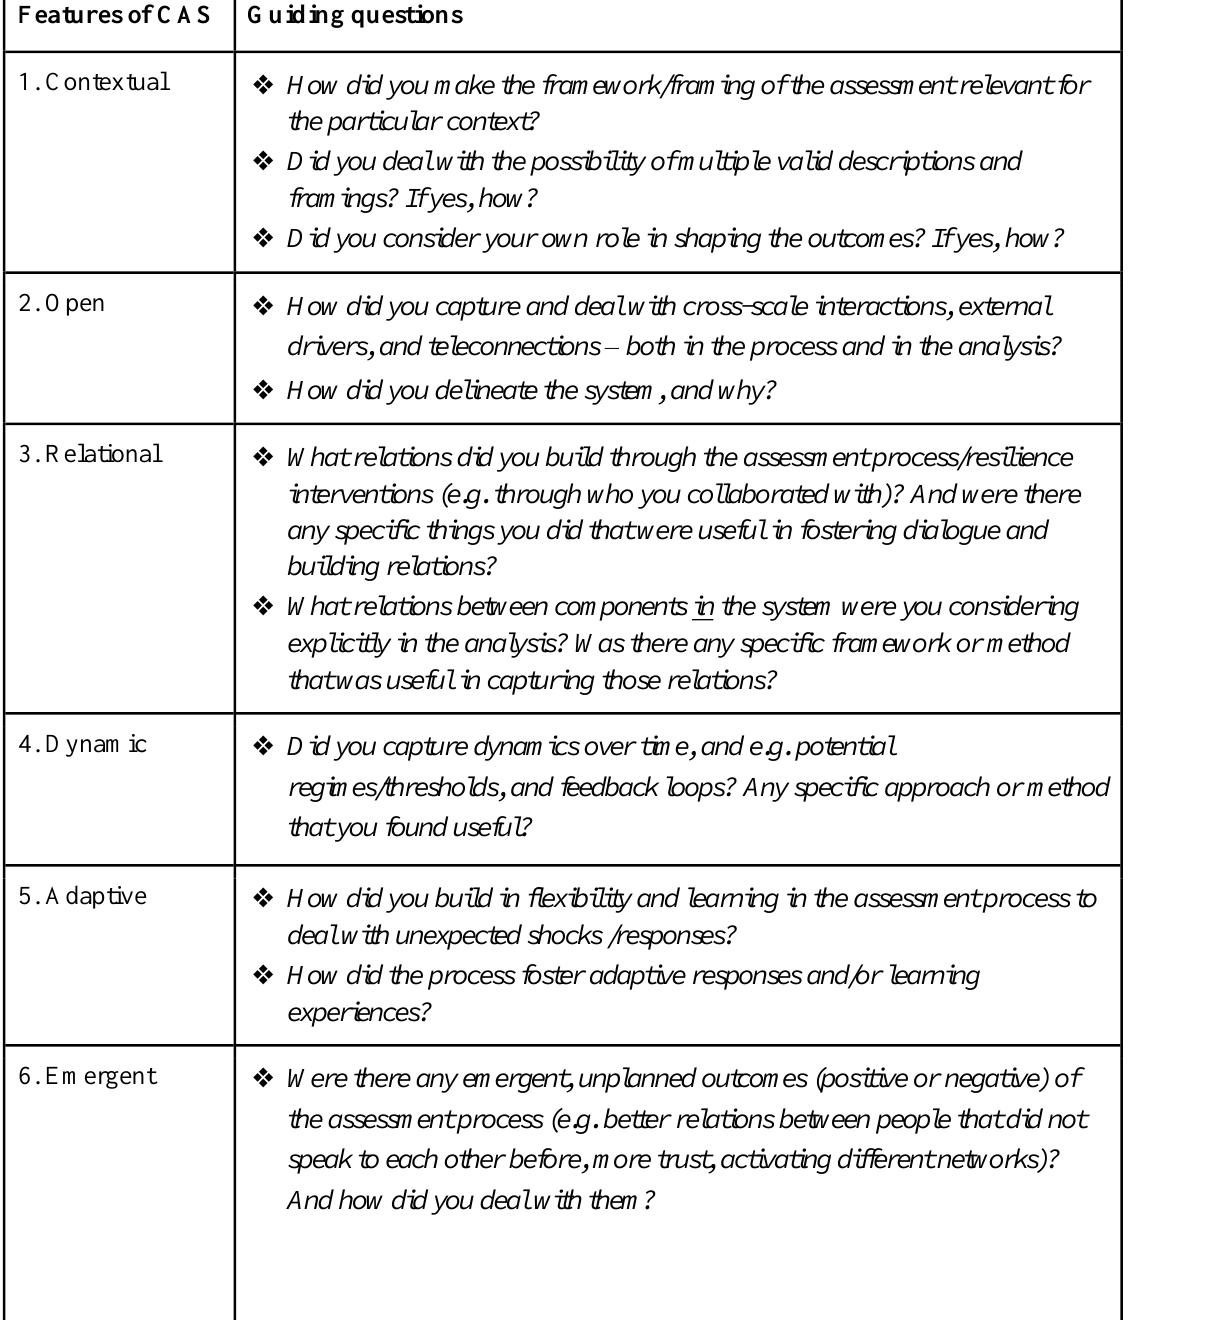
Table A1. Guiding questions for assessing how cases of resilience practice engaged with